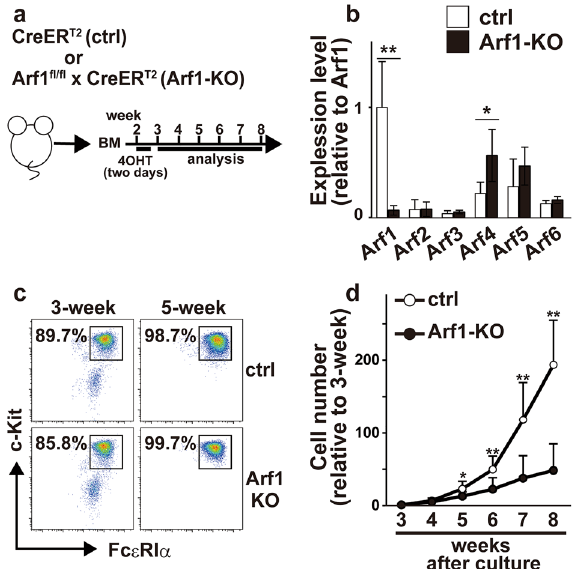
Figure 1. Characterization of Arf1-deficient BMMCs. ( a ) Schema of the BMMC culture. ( b ) Quantitative PCR (qPCR) analysis of expression levels of Arf family members relative to Cyclophilin A in BMMCs derived from control (ctrl) and Arf1-KO mice (n = 6, each). Shown are relative expression levels normalized to Arf1 in control mice (mean ± SD). ( c ) Flow cytometric profiles of c-Kit + FcεRIα + cells at 3- and 5-week after culture. Shown are representative of eight independent experiments. ( d ) The cell numbers of BMMCs relative to those at 3-week after culture (n = 8, each). Mean ± SD. * p < 0.05, ** p <